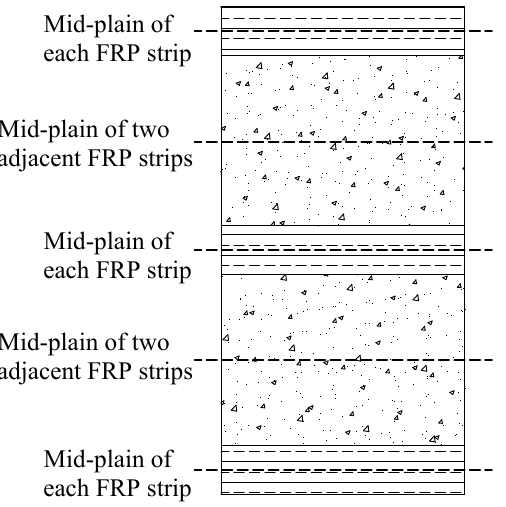
Figure 3. Illustration of the mid-plain of each FRP strip and the mid-plain of two adjacent FRP strips. To obtain in-depth understanding of partially FRP-confined concrete, the strains and stresses along the generatrix (column height) need to be understood appropriately. The strains distribution